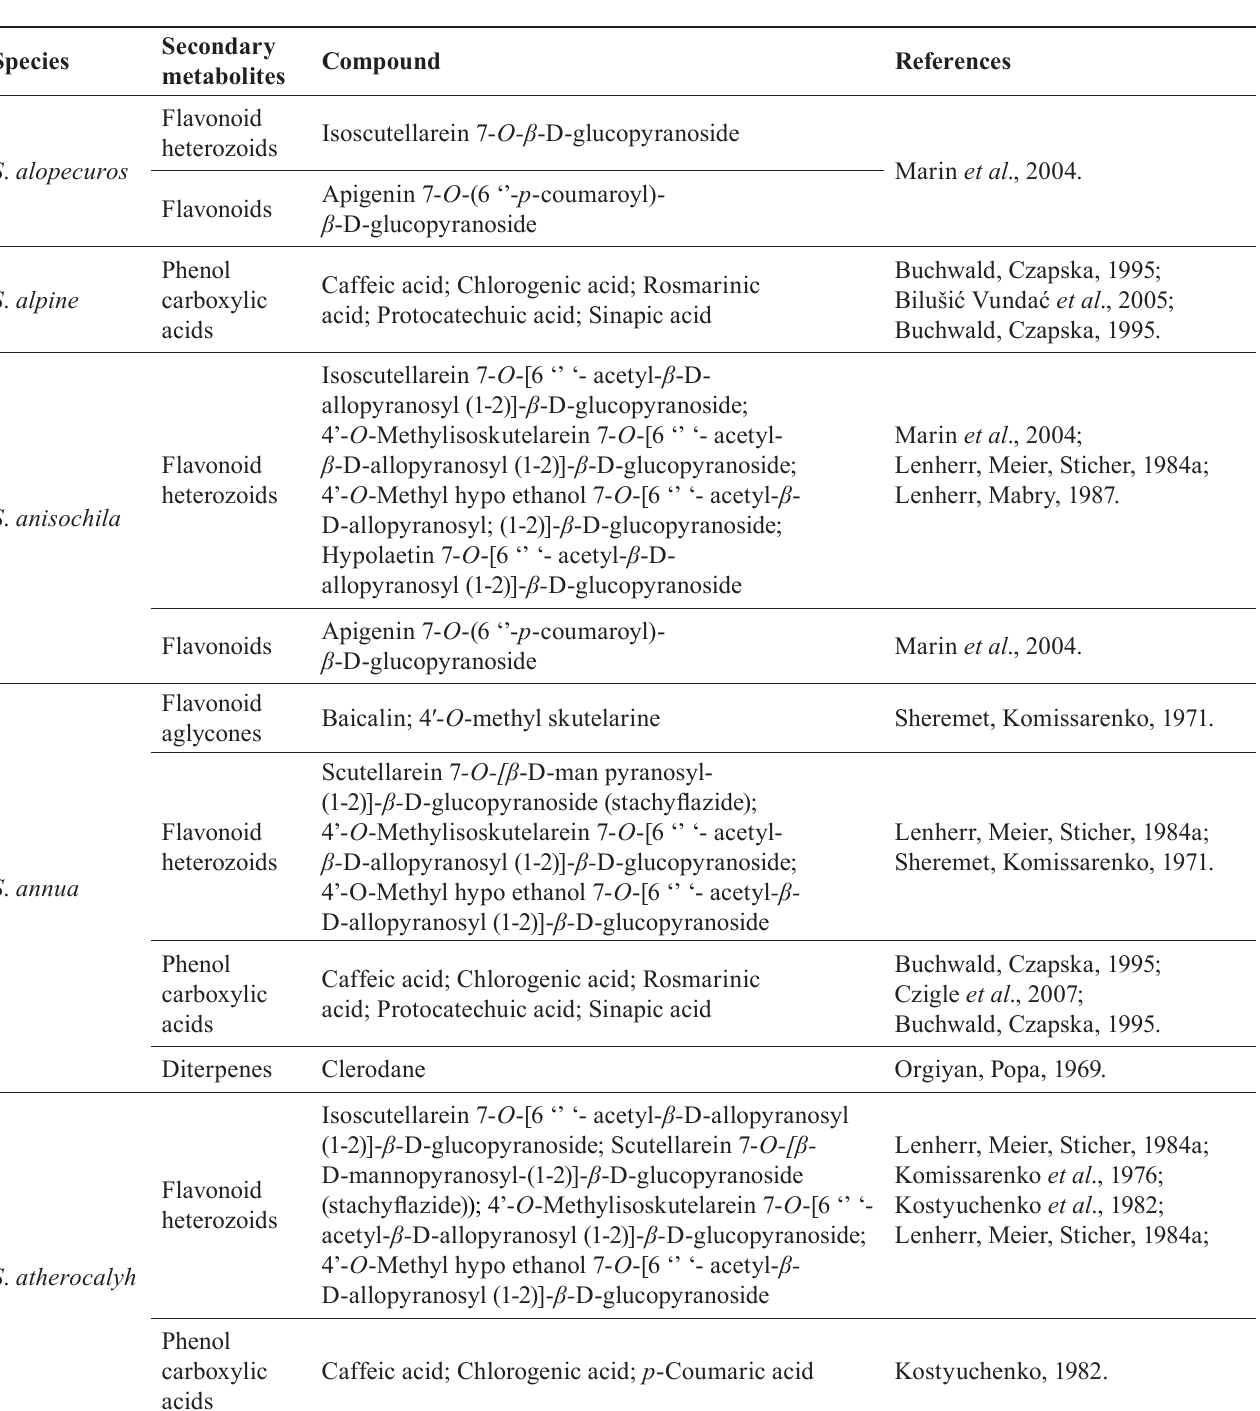
TABLE I - S econdary metabolites of Stachys species